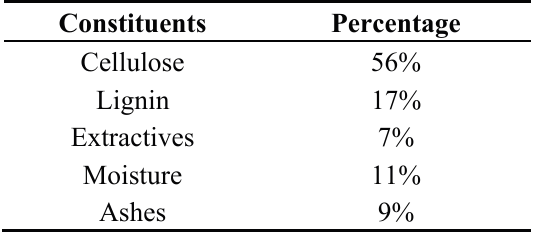
Table 1. Composition of studied banana trunk fibers